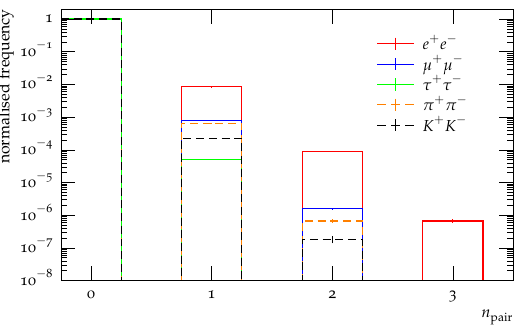
Figure 4 . The relative abundance of secondary pairs of each species of charged particle produced in photon splittings in the mixed ordering